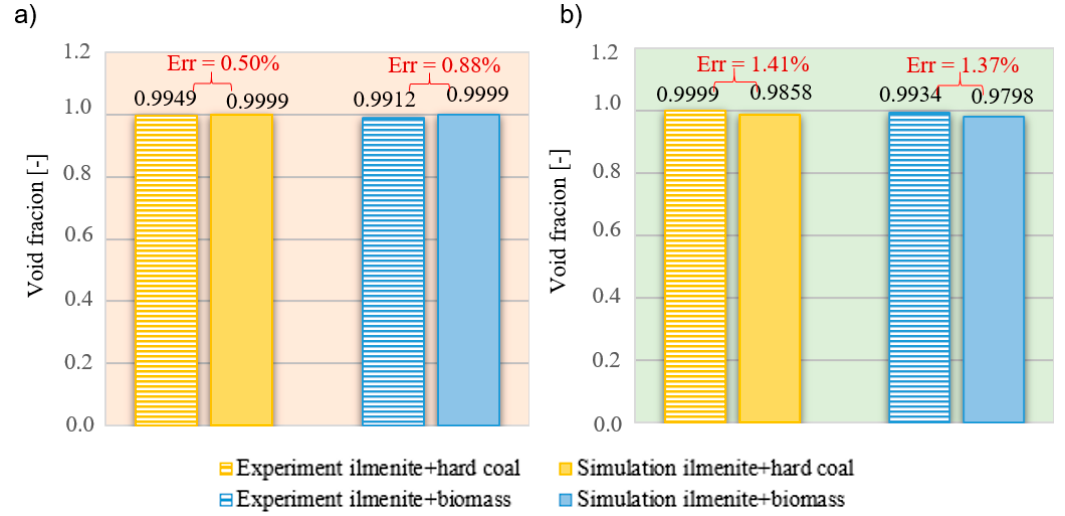
Figure 11. Experiment and simulation results for the lean region:( a ) AR ( b ) FR.